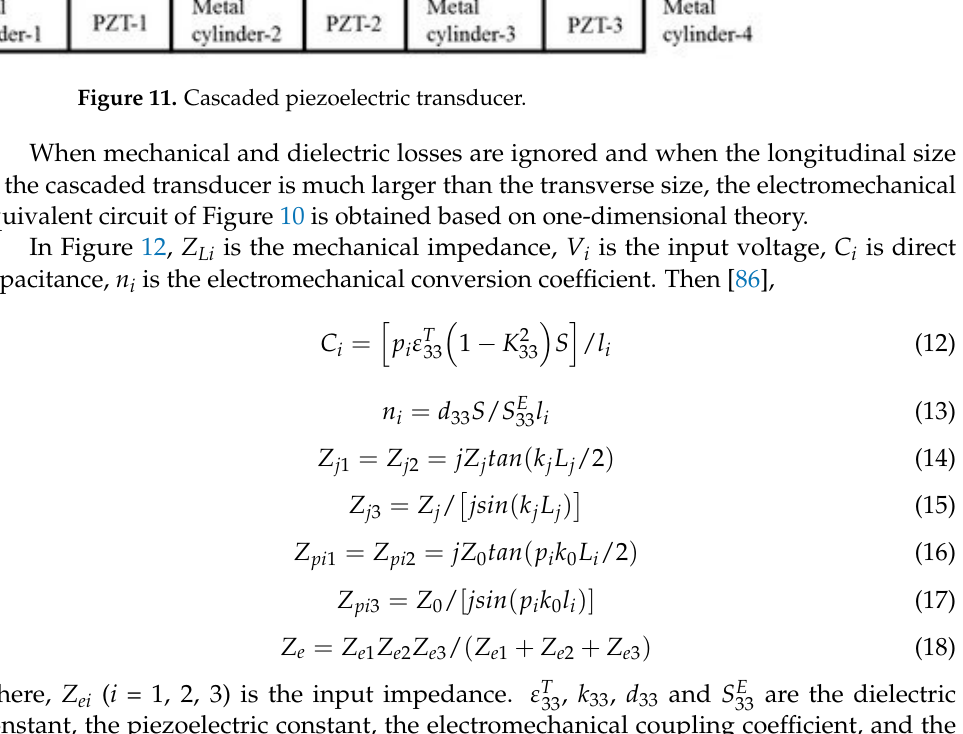
Figure 11. Cascaded piezoelectric transducer.